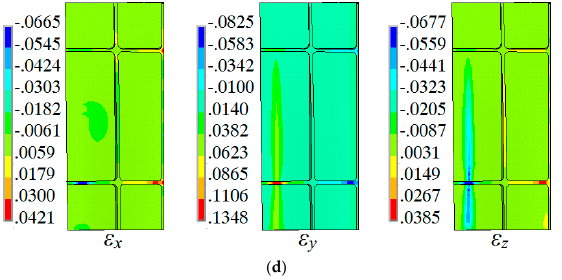
Figure 12. Normal strain components of GP in position A: ( a ) at t = 51 μ s; ( b ) at t = 139 μ s; ( c ) at t = 394 μ s; and ( d ) at t = 612 μ s.